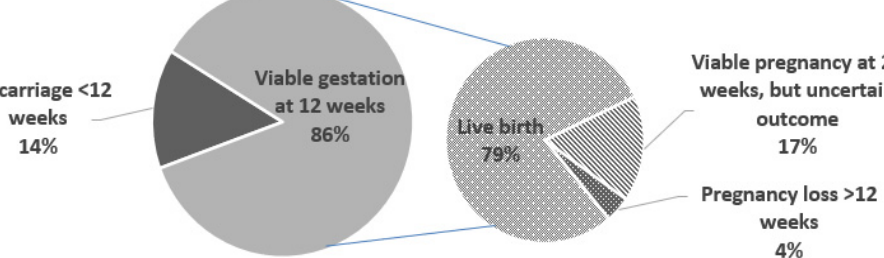
Figure 1. Pregnancy outcomes of the women enrolled on this prospective cohort.